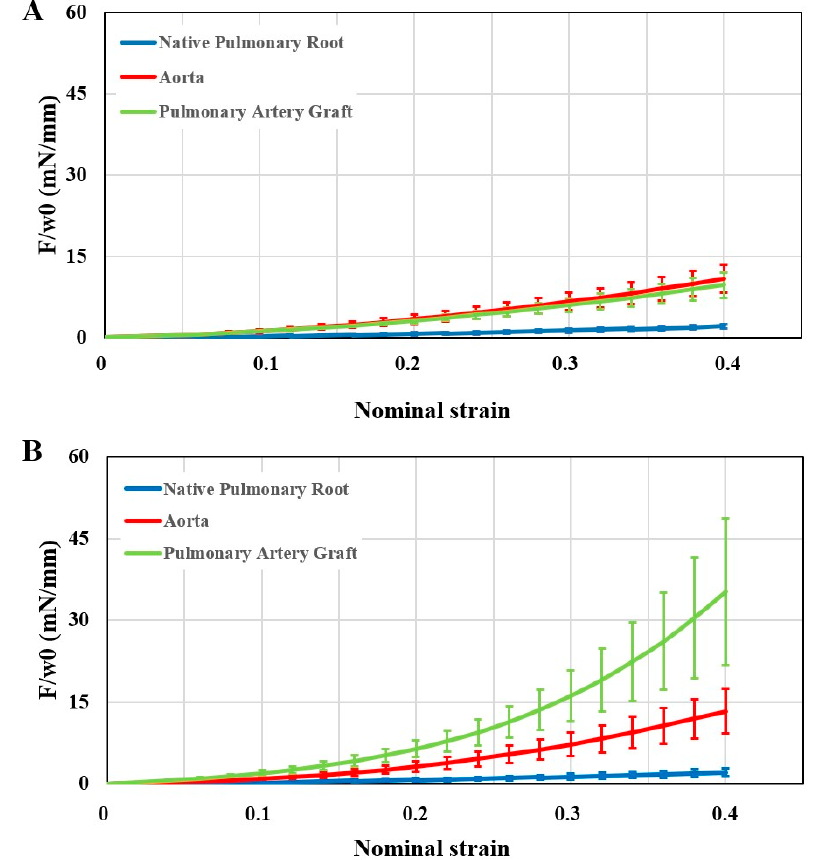
Figure 4. Graphs showing stiffness of the aorta (red), native pulmonary artery (blue), and PAG (green) at 1 week (( A ), n = 5) and 2 months (( B ), n = 10) after surgery. The x-axis shows the nominal strain and the y-axis the membrane force. Values are expressed as mean ± standard error of the mean. F: tensile force; w0: initial width.